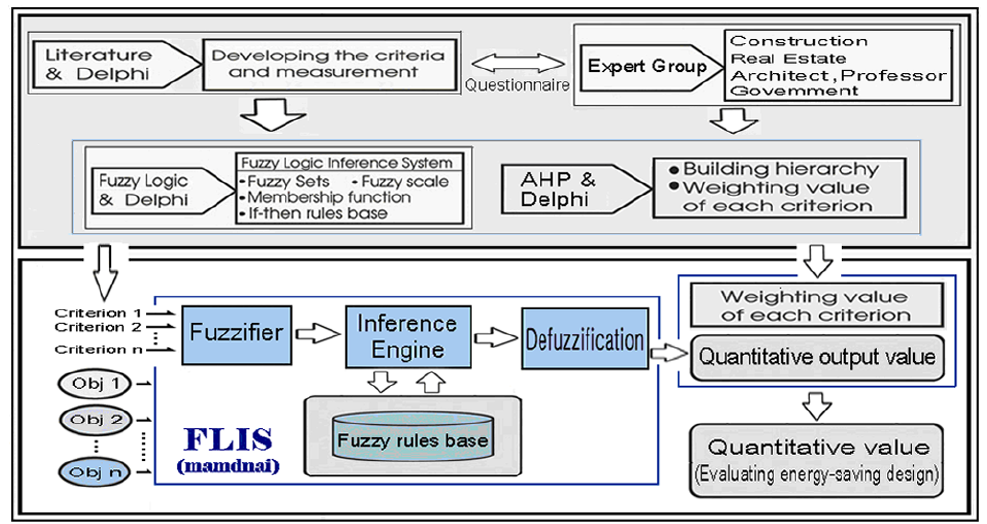
Figure 1. Framework of the evaluation